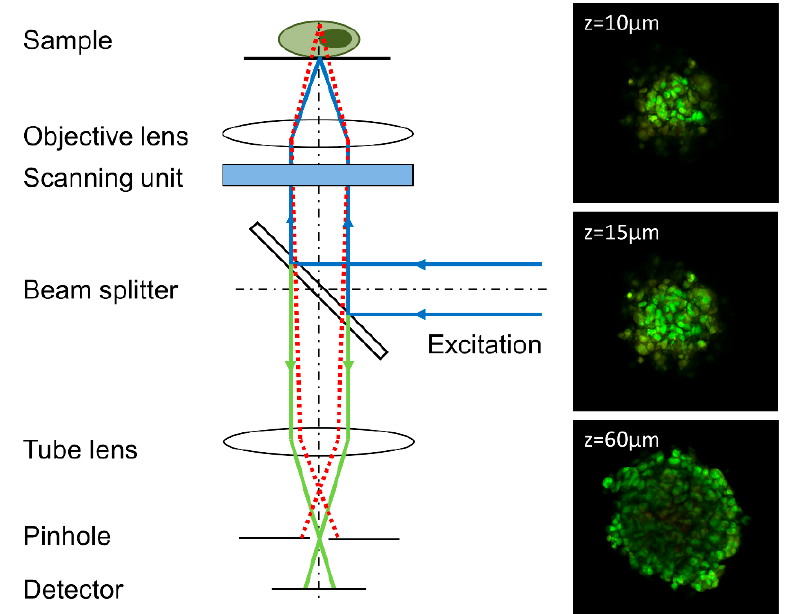
Figure 3. Principle of a confocal laser scanning microscope (CLSM); only a confocal beam passes the pinhole, whereas non-confocal beams are blocked. Moving of the sample in vertical direction allows imaging of different planes. Example: Focal planes of a spheroid of U373-MG glioblastoma cells incubated with acridine orange (5 µM, 40 min.) at different distances from top of the sphere (excitation wavelength: 488 nm, fluorescence detection: ≥ 505 µm, image size: 460 µm × 460 µm). Reproduced in parts from [33].